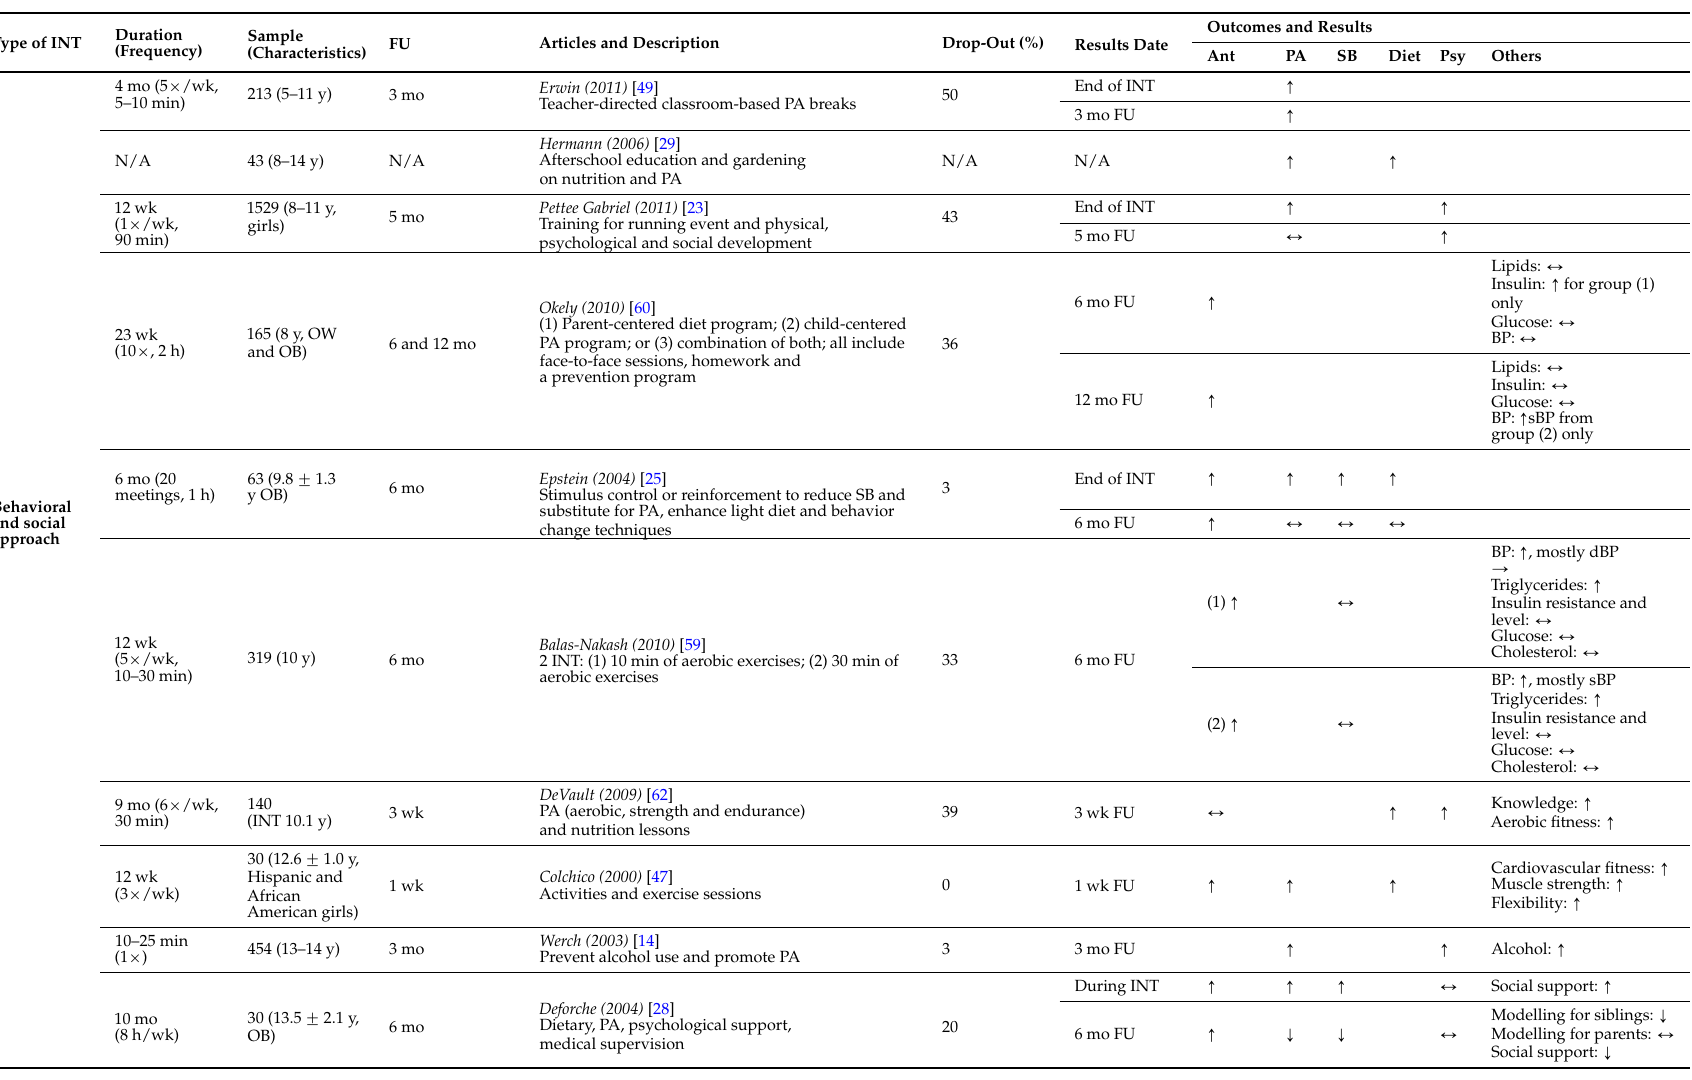
Table 2. Physical activity interventions without control groups ( n =